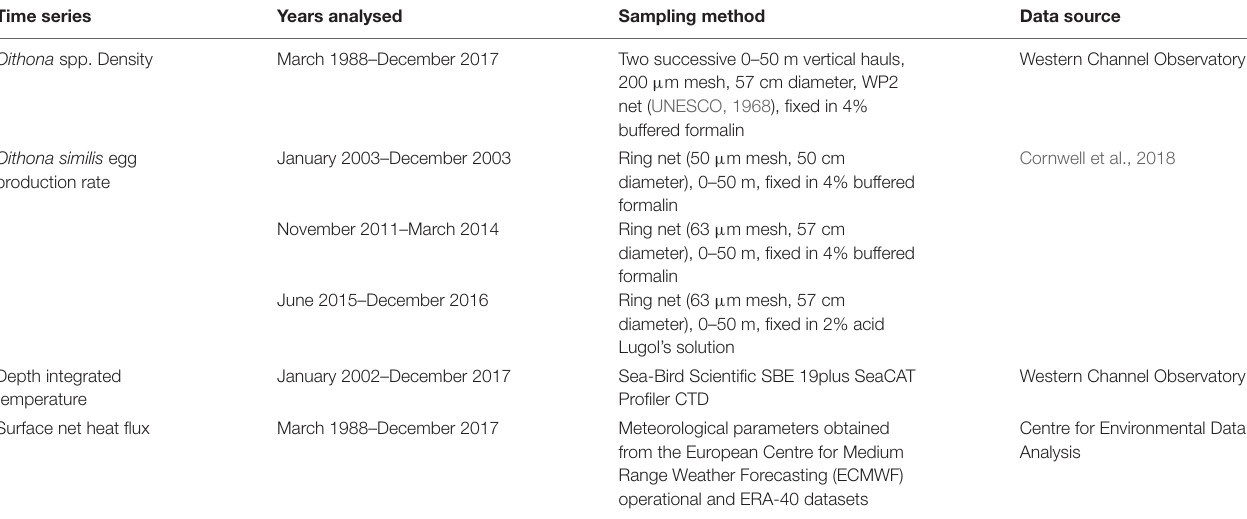
TABLE 1 | The duration, sampling methodology, and sources of all datasets analysed in the present study. Time series Years analysed Sampling method Oithona spp.